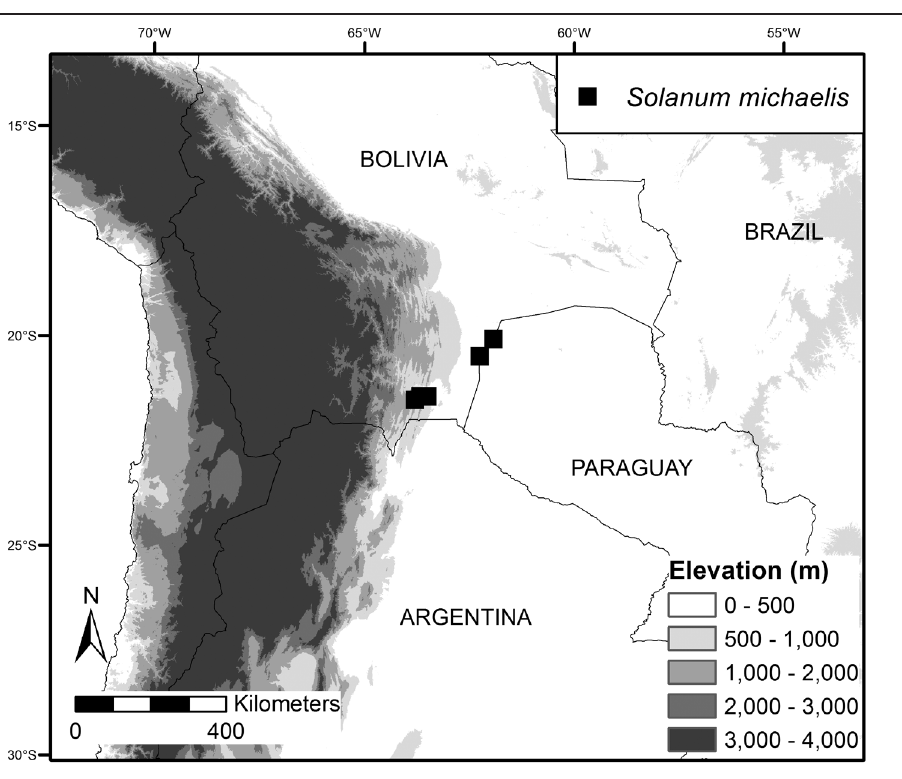
Figure 2. Distribution map of Solanum michaelis